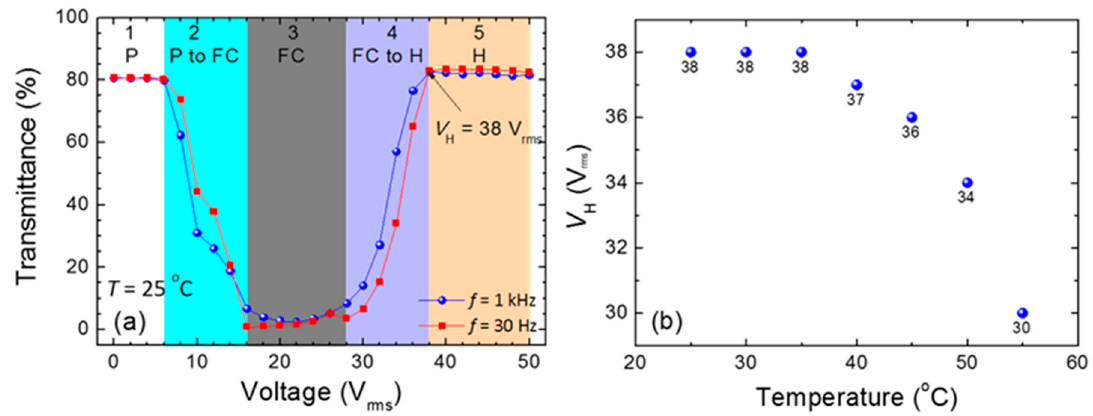
Figure 1. ( a ) Voltage dependence of the transmission of the CLC cell under AC voltage applied at T = 25 ◦ C and ( b ) the change of the critical voltage ( V H ) for helix unwinding as a function of temperature. Regions 1, 3, and 5 in Figure 1a are voltage ranges for sustaining the cell in the P, FC, and H states, respectively. Regions 2 and 4 reveal V − T % behaviors, dominated by the P to FC and FC to H textural transitions, respectively.